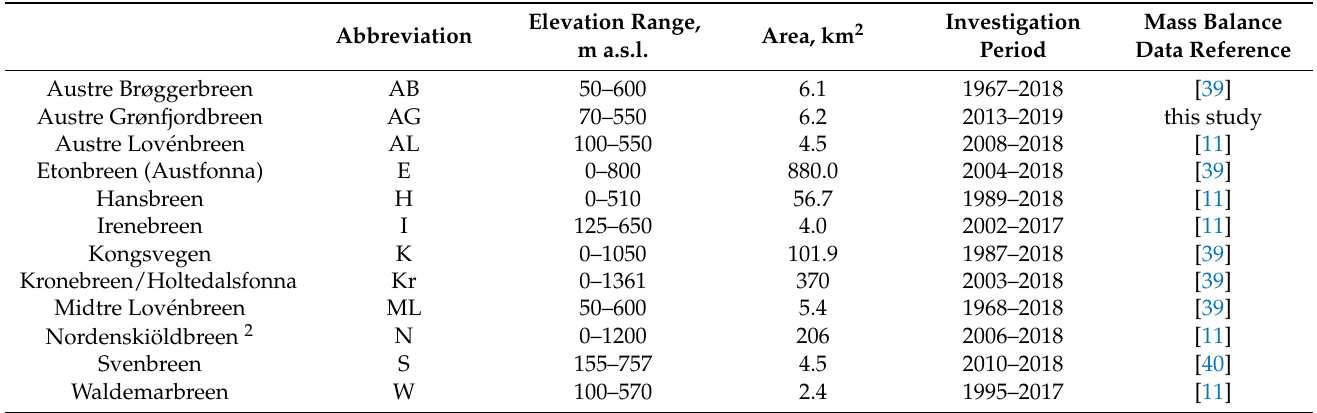
Table 6. The list of Svalbard glaciers with glaciological mass balance measurements considered in this